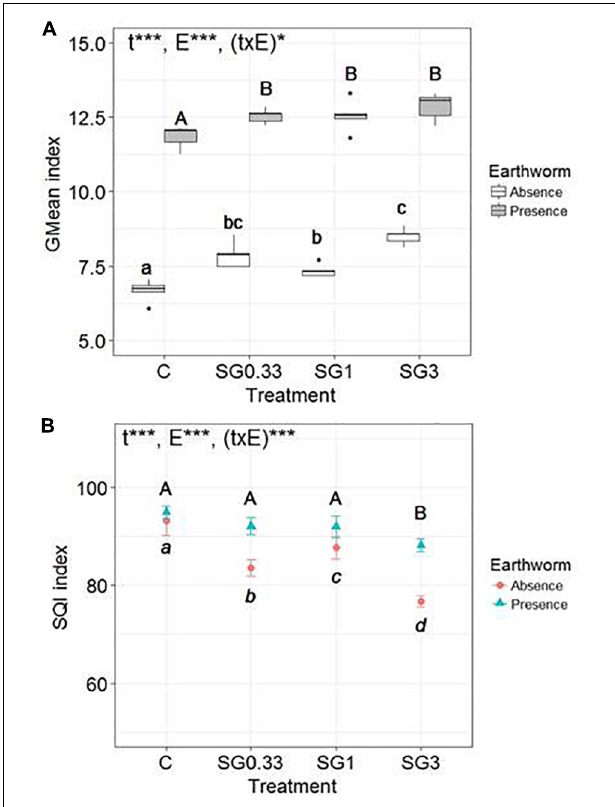
FIGURE 2 | Box-plots of (A) the geometric mean (GMean index) and (B) the Mean values ( n = 5, ± SD) of the Soil Quality Index (SQI) of microbial activities ( β -D-glucosidase, phosphatase, urease and arylamidase, potential nitrification activity) in soils spiked with different Swing R (cid:13) Gold concentrations (0.33, 1, and 3 times the RD abbreviated SG0.33, SG1 and SG3, respectively) and a control soil, in the presence or in the absence of earthworms. Different letters mean significant differences between treatments, and the result of the two-way ANOVA test is presented as follows: “t” is for treatment effect, “E” for earthworm effect, and “(txE)” for their interaction. “ns” means no significant difference, ∗ p < 0.05 and ∗∗∗ p <